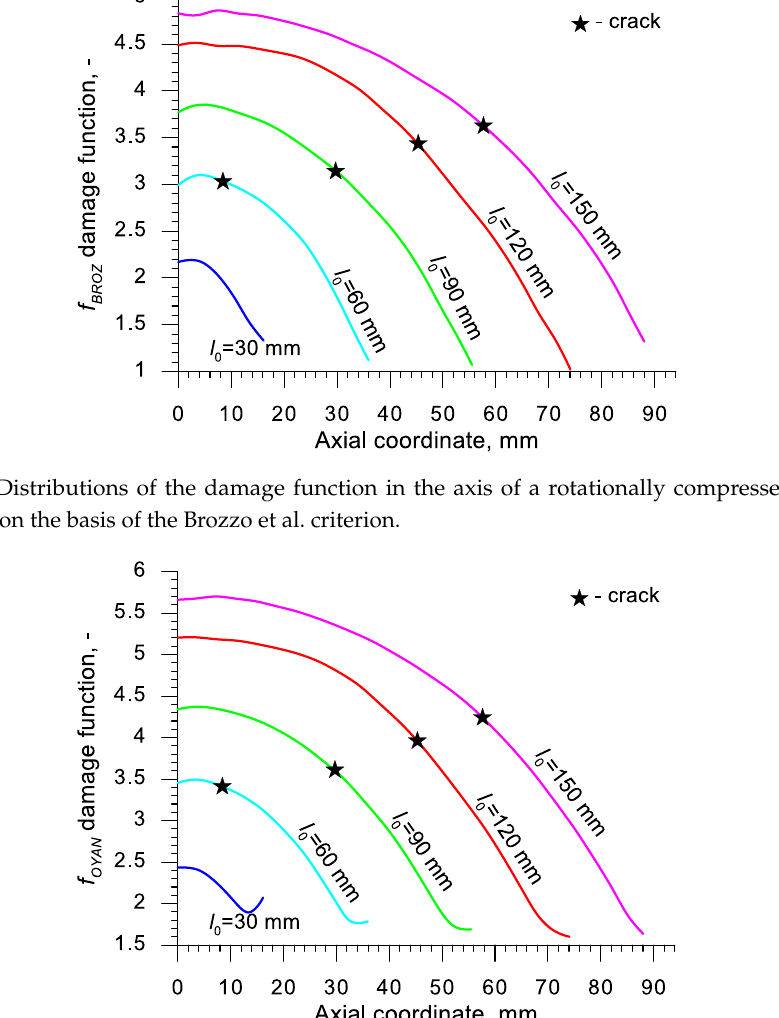
Figure 22. Distributions of the damage function in the axis of a rotationally compressed sample, determined on the basis of the Oyane criterion.